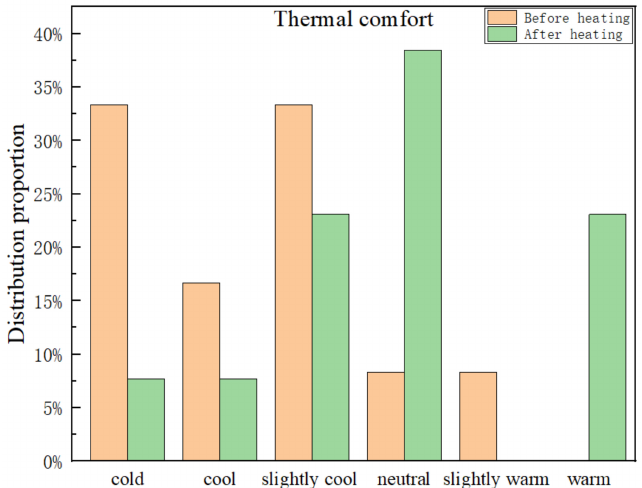
Figure 19. Thermal comfort evaluation